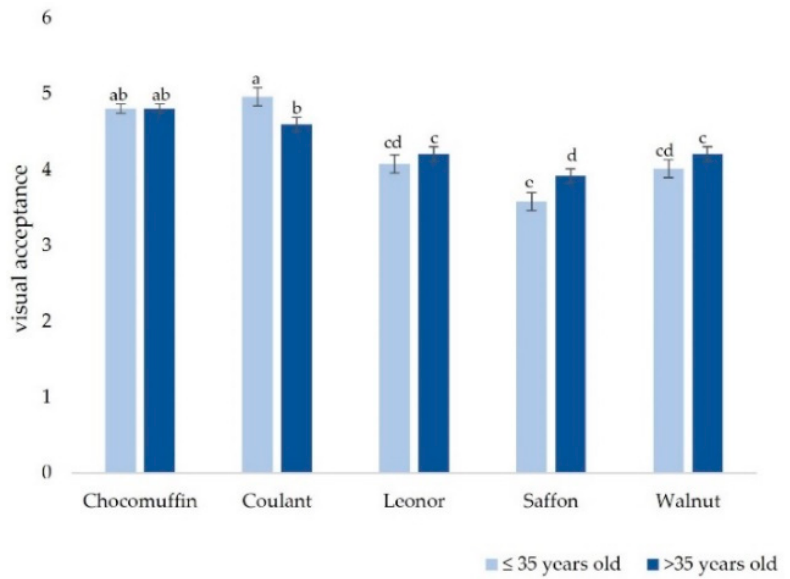
Figure 2. Average visual acceptability classified by cake and age group. The different lowercase letters on the columns indicate the significantly different groups according to Tukey’s test.